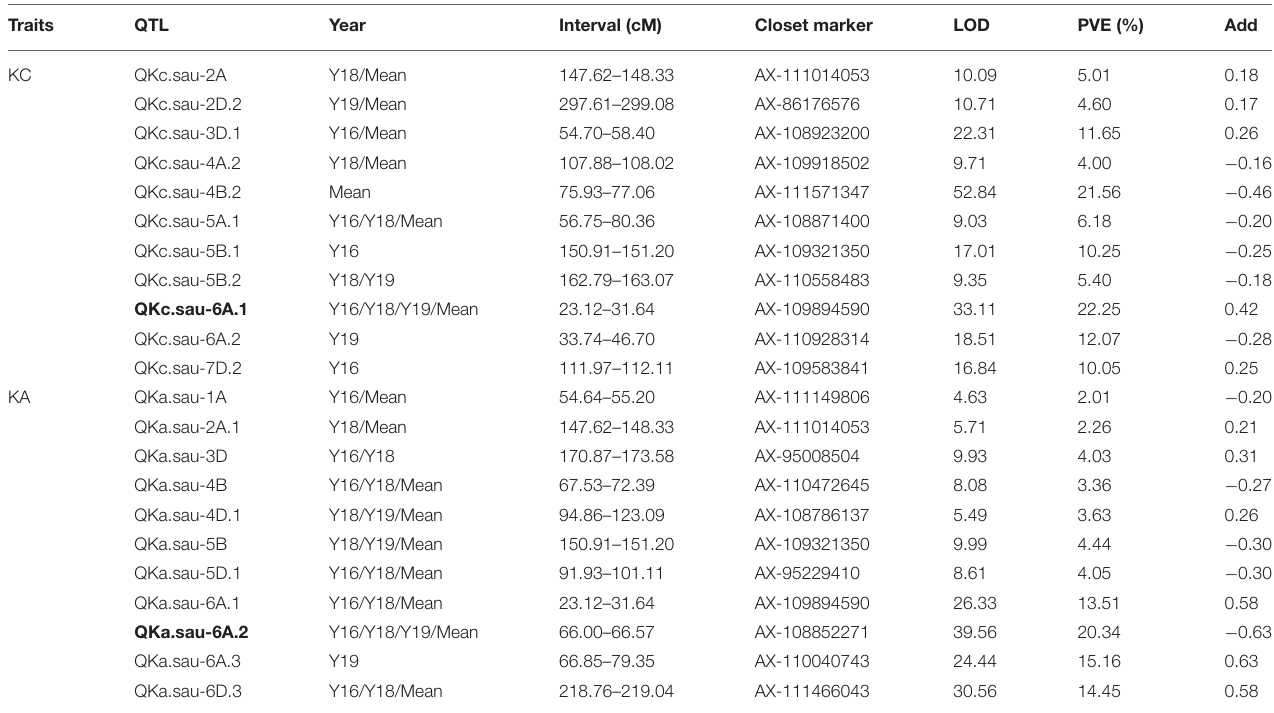
TABLE 3 | Major QTL mapping results of single environment analysis.